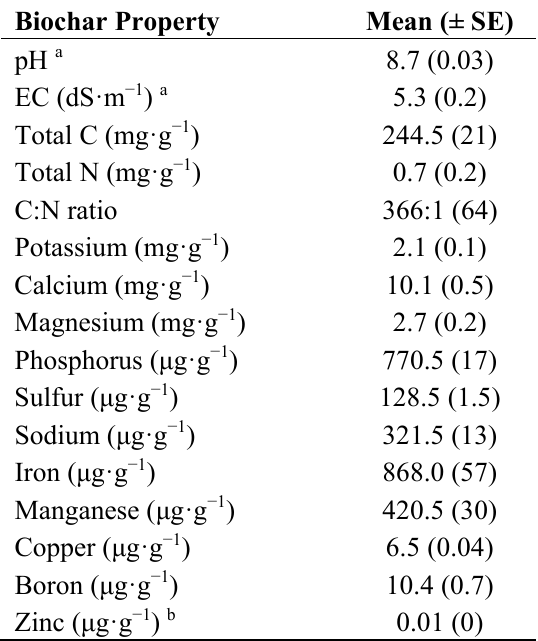
Table 1. Initial mean (± standard error (SE)) pH, electrical conductivity (EC), total carbon (C), total nitrogen (N), C:N ratio, and total recoverable mineral concentrations determined using a nitric acid digest for pine ( Pinus spp.) woodchip biochar ( n = 2).